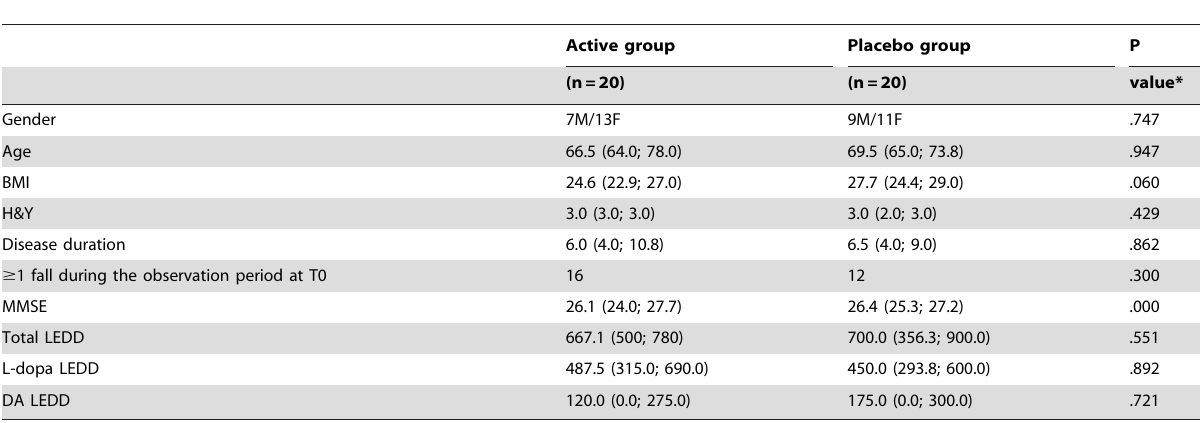
Table 1. Baseline demographic and clinical variables of the two groups enrolled in the study.